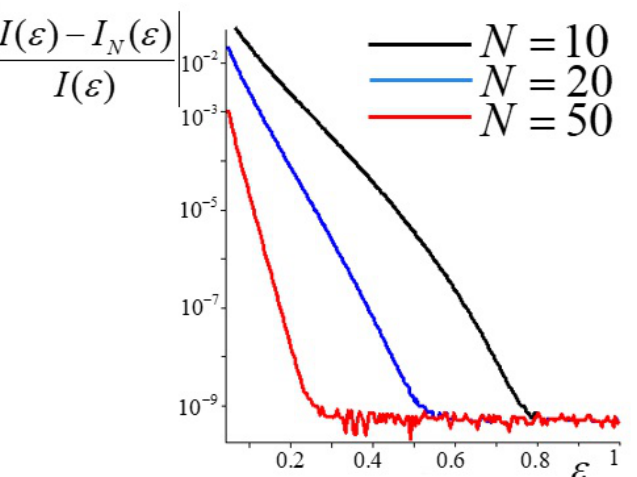
| for N = 10, N = 20, and N = 50. The scale is Figure 2. Plots of the relative error | I ( (cid:101) ) − I N ( (cid:101) ) I ( (cid:101) ) logarithmic. The peaks at the level of 10 − 9 are due to the numerical round-off error, since the calculation has been performed with 10 significant